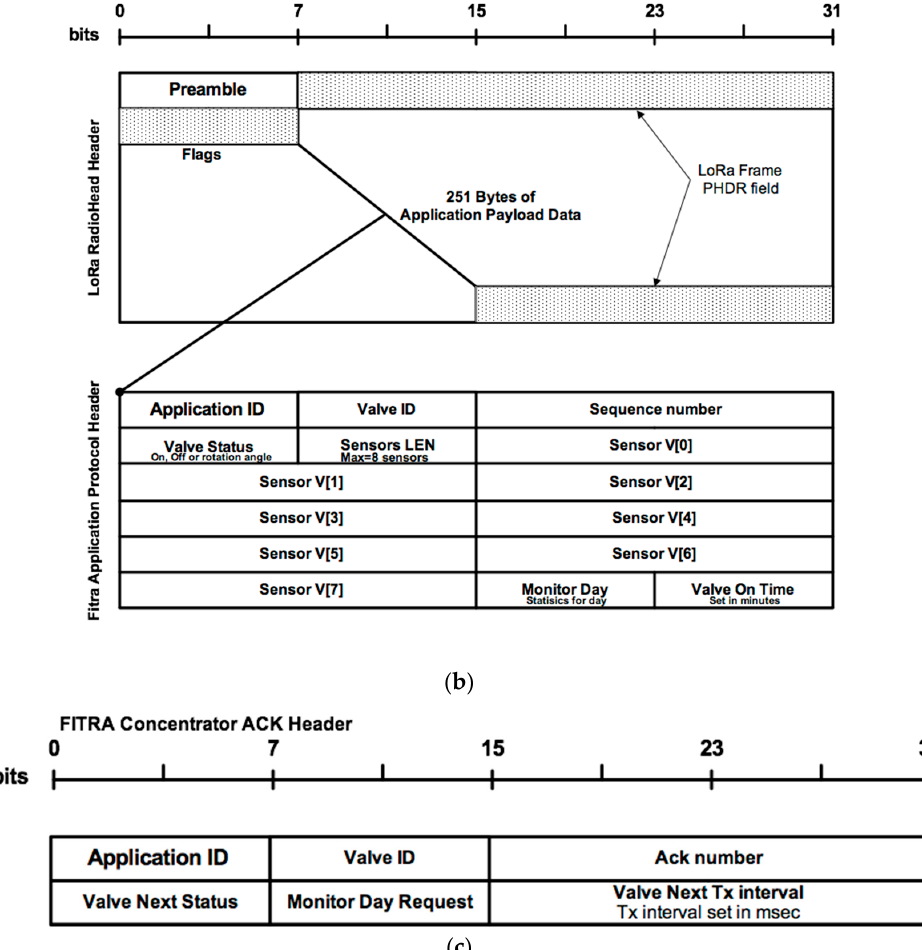
Figure 6. ( a ) LoRaWAN communication protocol packet structure for class A transmission over LoRa 868 MHz network [37]; ( b ) FITRA communication protocol packet structure for transmission over LoRa radio 433 MHz network; ( c ) FITRA concentrator communication protocol ACK packet structure for transmission over LoRa 433 MHz network.